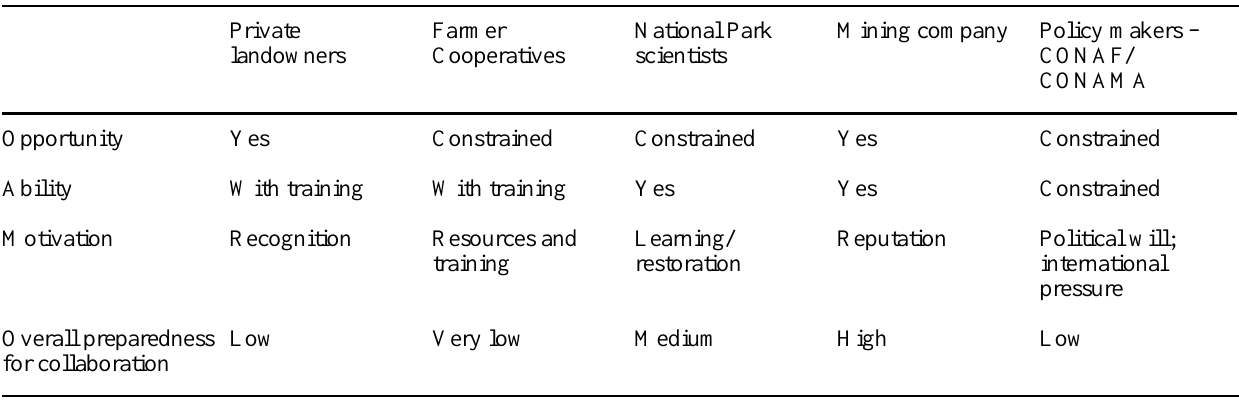
Table 3 . Opportunity, ability and motivation for collaboration in El Niño experiement Private